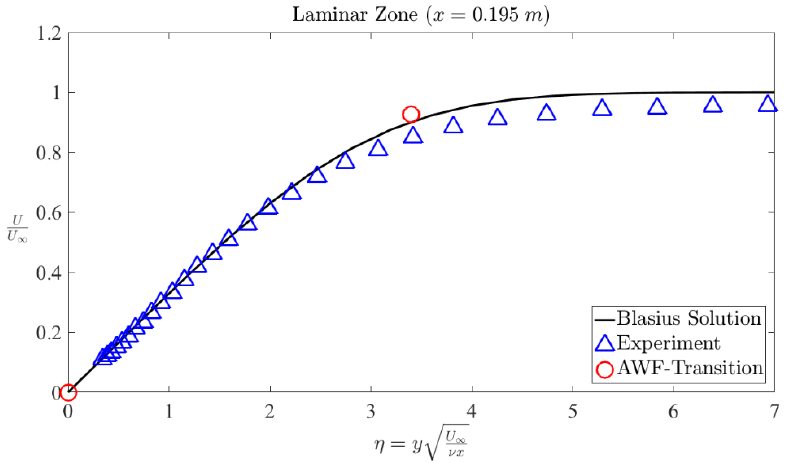
Figure 6. Velocity profile of T3A in the laminar zone.